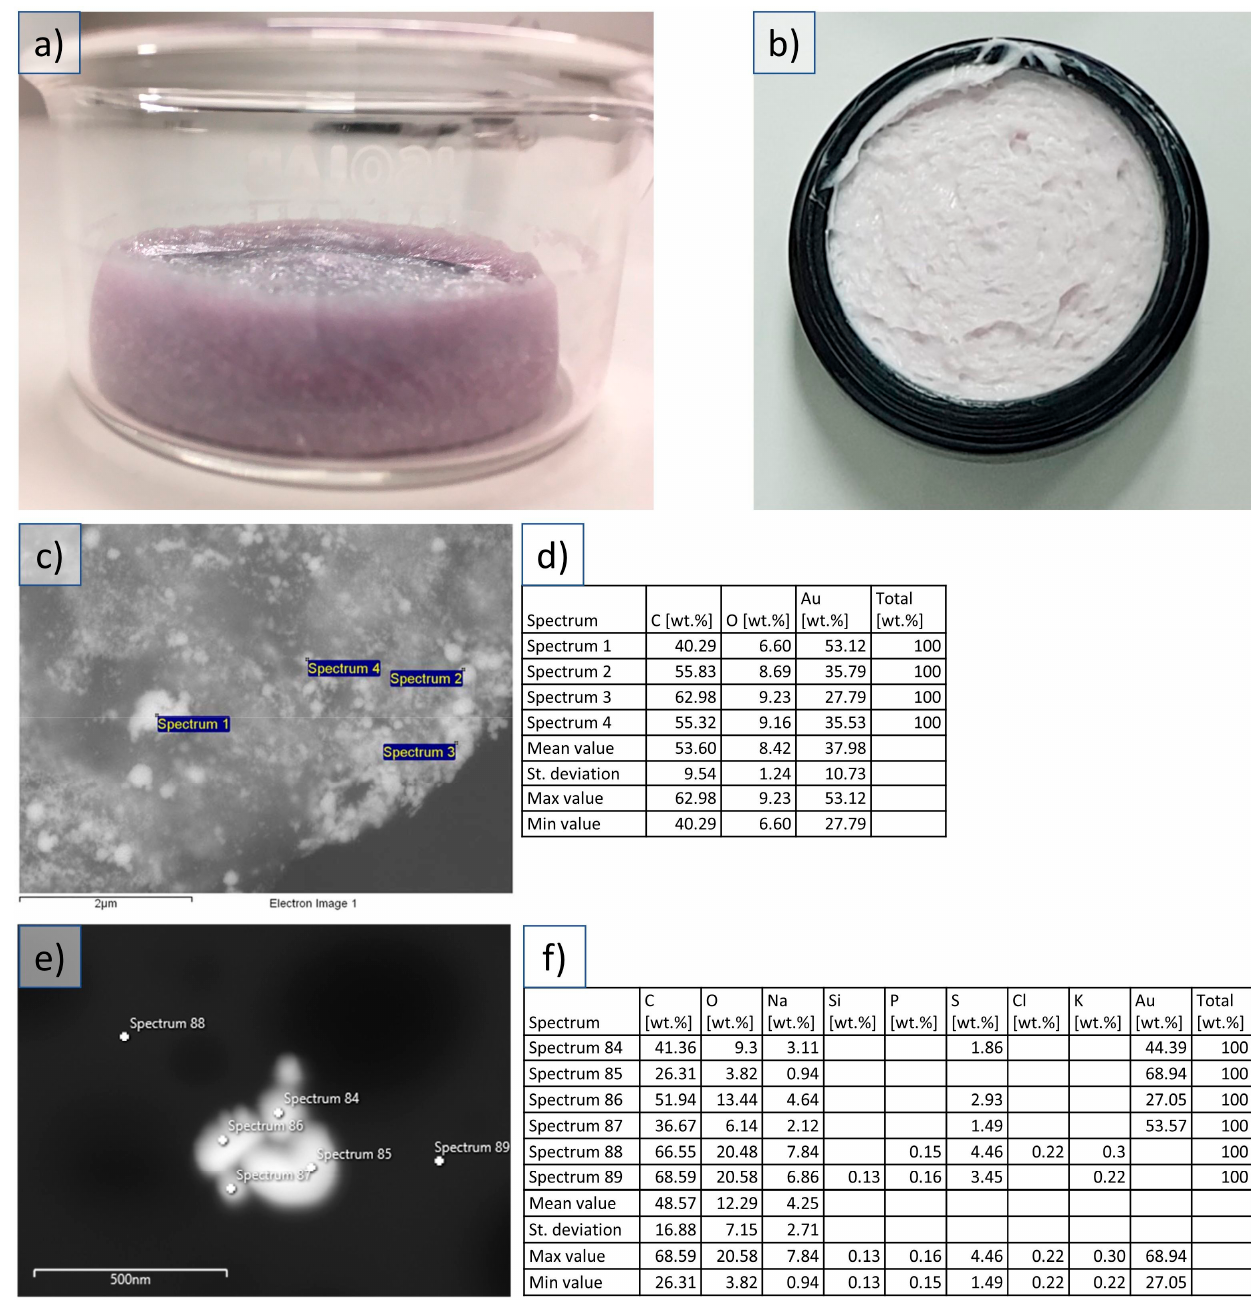
Figure 1. Dried AuNPs, cosmetic cream with AuNPs, and SEM examinations. ( a ) Freeze-dried PVP cake with AuNPs. ( b ) Cosmetic cream with embedded AuNPs. ( c ) SEM image of the dried AuNPs. ( d ) EDX analysis of select points in the corresponding SEM image of the dried AuNPs. ( e ) SEM image of the AuNPs embedded in the cosmetic cream. ( f ) EDX analysis of select points in the corresponding SEM image of the AuNPs embedded in the cosmetic cream.